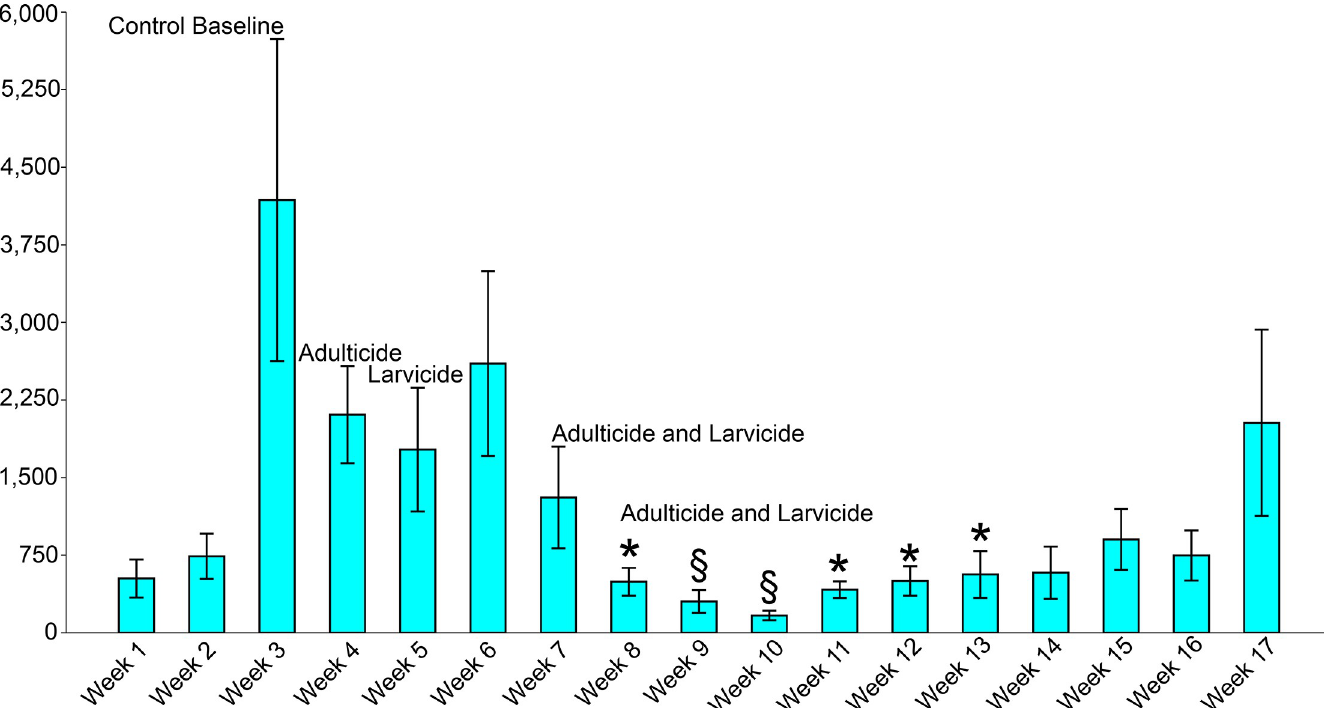
Fig 4. Bar chart displaying the effect of insecticide intervention in the abundance of adult Ae . aegypti at the study area in Miami-Dade County, Florida. Each bar displays the mean value; the whisker interval represents a 95% confidence interval standard error. � = Significant values; § = Statistically significant values after multiple testing adjustment with Bonferroni. https://doi.org/10.1371/journal.pone.0246046.g004 PLOS ONE | https://doi.org/10.1371/journal.pone.0246046 January 25,